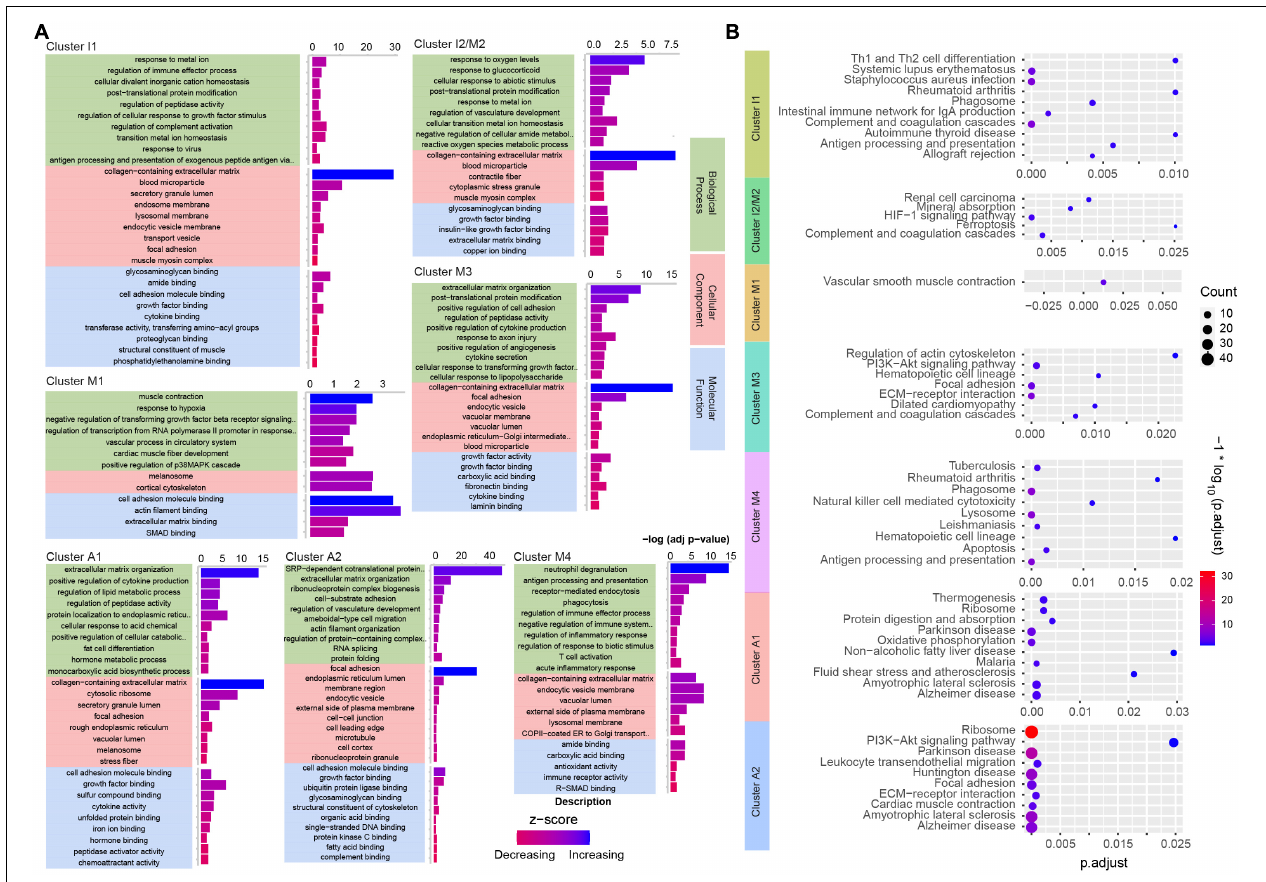
FIGURE 5 | Analysis of GO and KEGG enrichment of clusters in ascending aortic dissection tissue. (A) Analysis of genes enriched by GO terms (biological processes, cellular component, molecular function) (p. adjust) in each cluster. The function is reflected by z -score and up color-coded from red to blue. (B) KEGG analysis for hallmark genes of enriched pathways in each cluster. The gradient color represents the P -value; the size of the black spots represents the gene